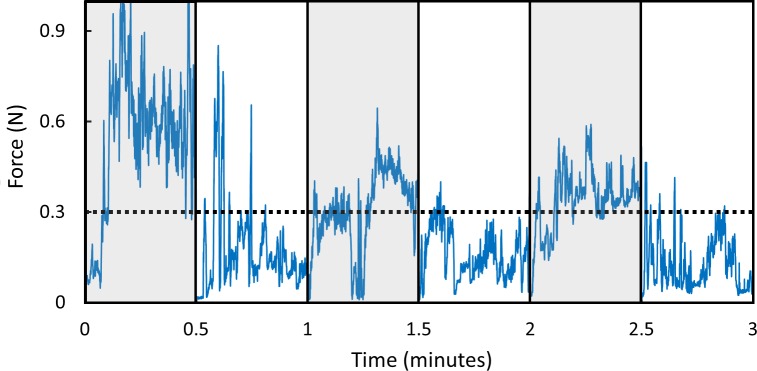
Force over time for the initial six 30 second periods of use during the in vivo study.Use of the standard instrument is denoted by a grey background and use of the force-limiting instrument with a white background.